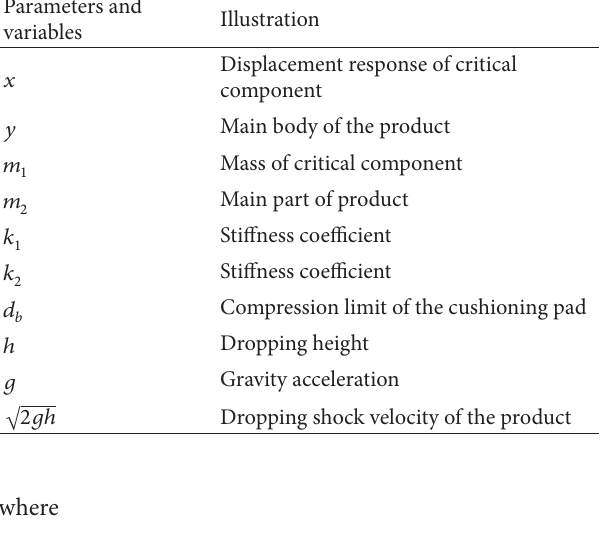
Table 1: List of variables and parameters (modified from [1, 4]). Parameters